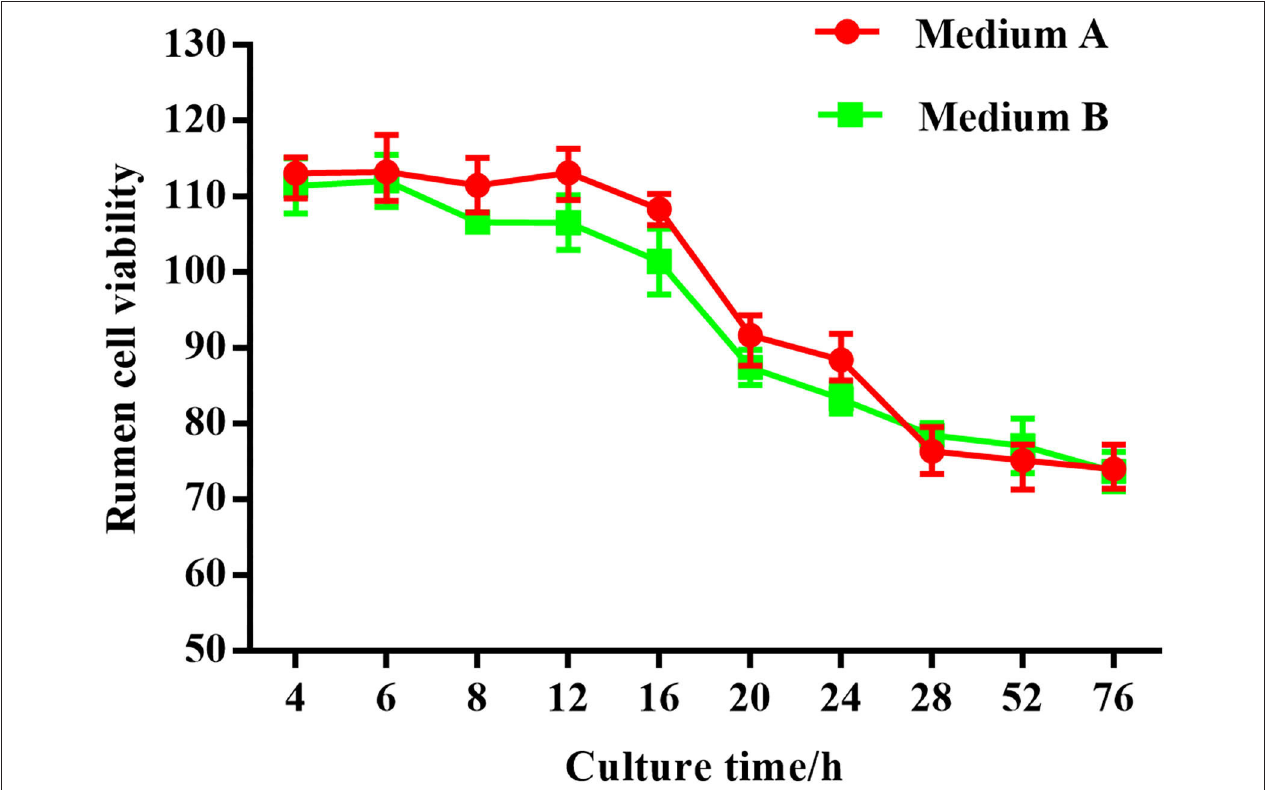
FIGURE 3 | Effect of different concentrations of Bacillus subtilis IIIVE-4 on the cell activity of rumen explants was determined by MTT. Different concentrations of living and inactivated Bacillus subtilis IIIVE-4 had no significant effect on explant